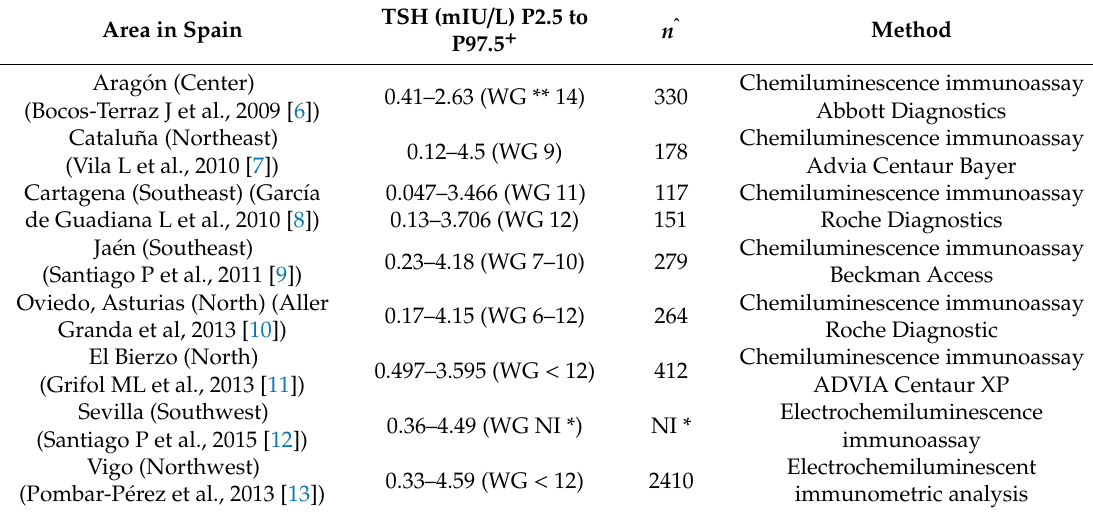
Table 1. Di ff erent reference values of thyroid stimulating hormone (TSH) in Spain in the first trimester of